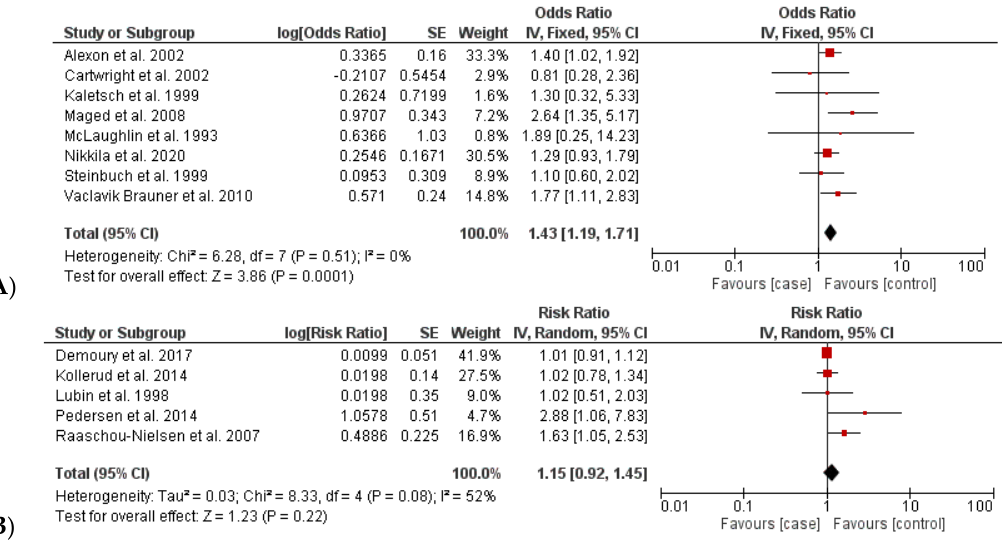
Figure 3. Comparison of incidence of radon-caused childhood leukemia between case and control groups: ( A ) analysis based on OR values [11,12,16,32,63,64,66,67] and ( B ) analysis based on RR values [28,30,31,33,65]. ( B ) Red color: OR/RR values of individual studies, Black color: pooled OR/RR of the comparison.